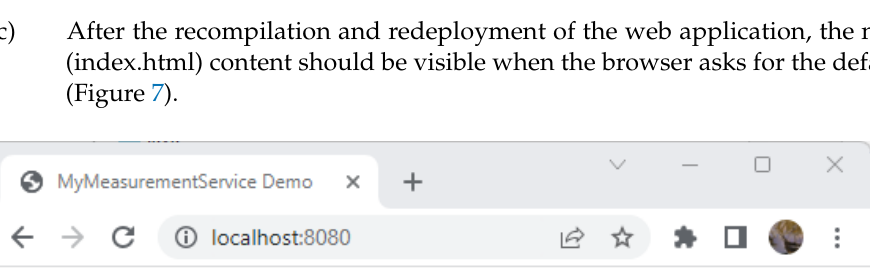
Figure 6. Static index.html file for the web application.